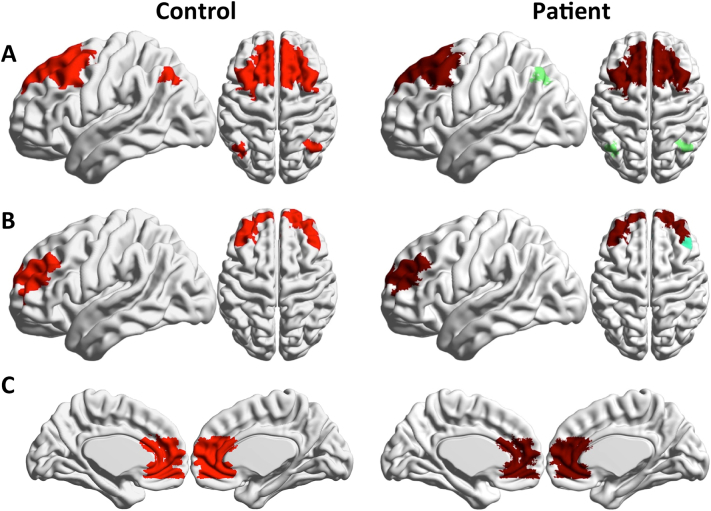
Module 3, 6 and 11 (A, B and C, corresponding to prefrontal and frontal cortices) of the control group (left), and overlapping modules in the patient group (right). Local modular structure appears consistent between the two groups, with reduction in long-range fronto-parietal connectivity is observed in Module 3.